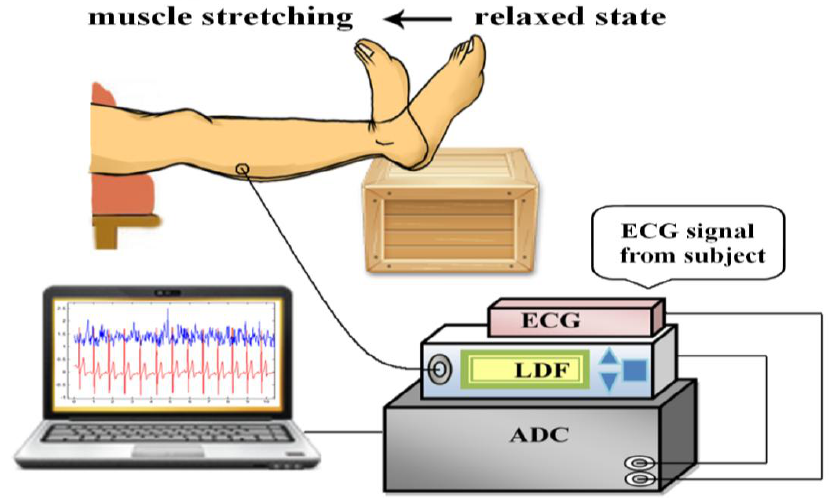
Figure 1. The measurement system, the location of the measurement site of microvascular perfusion, and active gastrocnemius muscle stretching with ankle dorsiflexion.